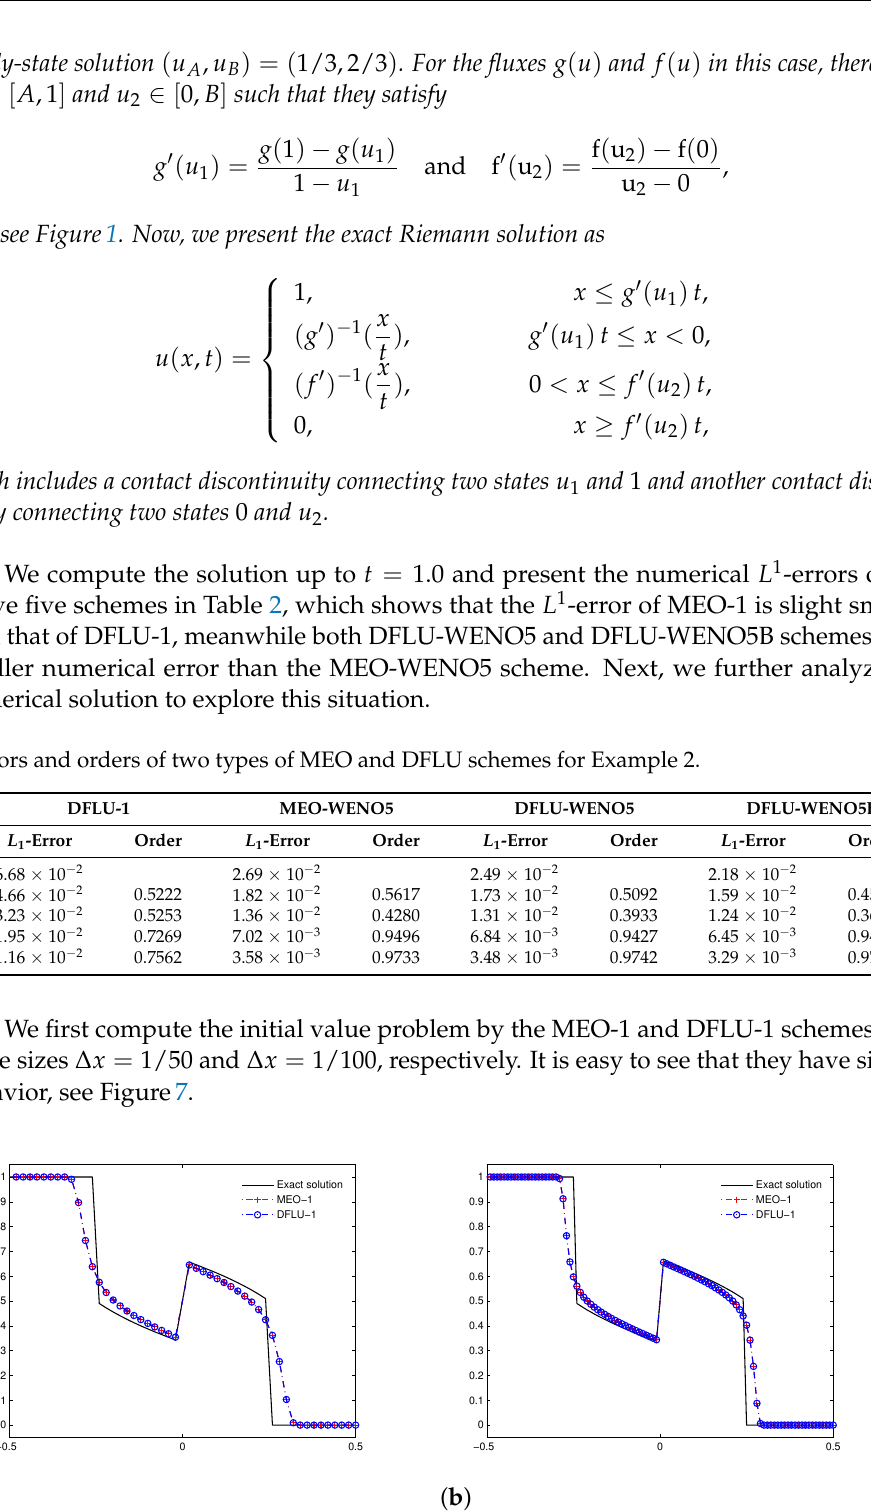
Figure 7. Example 2: Numerical solutions computed by the MEO-1 and DFLU-1 with the different meshes. ( a ): ∆ x = 1/50; ( b ): ∆ x =